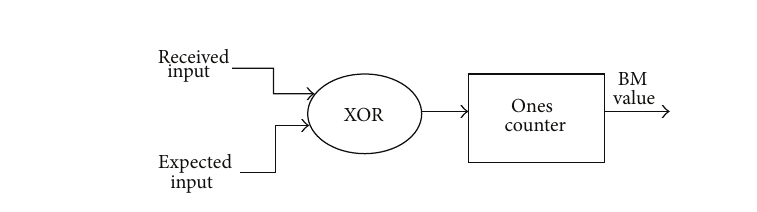
Figure 2: BMU for one